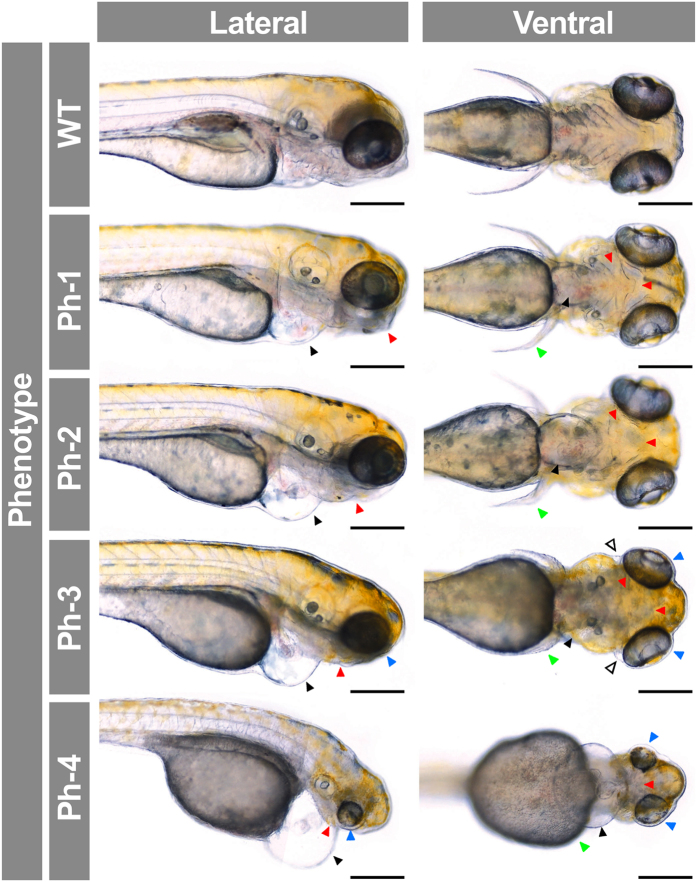
Analysis of gpatch3 knock-down-associated phenotypes in zebrafish morphant embryos.Gpatch3ATG MO-injected zebrafish embryos were analyzed at 96 hpf, and four phenotypes (Ph-1-4) with increasing severity were described. Lateral and ventral brightfield micrographs show altered phenotypes including microphthalmia (blue arrowheads), mouth and branchial arches (red arrowheads) and pectoral fins (green arrowheads) maldevelopment and pericardial (black arrowheads) and periocular (empty arrowheads) edemas. Scale bars represent 200 μm.